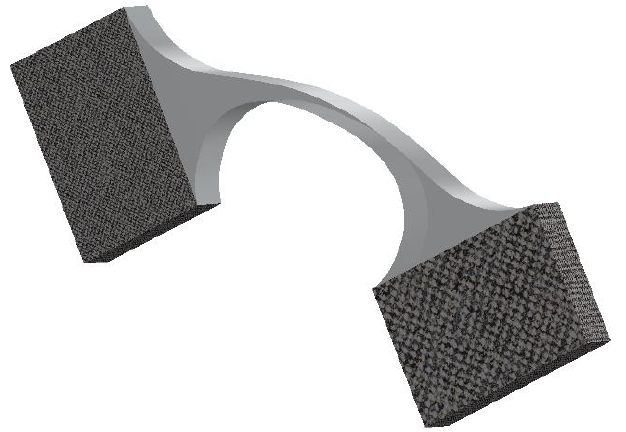
Figure 1. Connection of two rigid bodies through a flexure